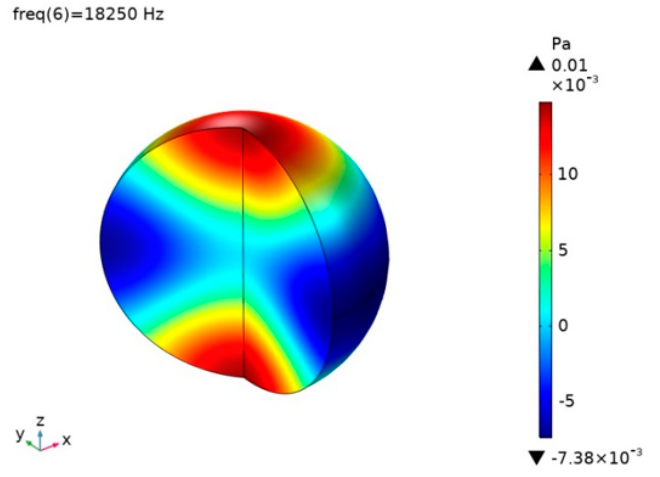
Figure 4. Acoustic pressure distribution of the SPAC at the second-order angular resonant frequency of 18,250 Hz.